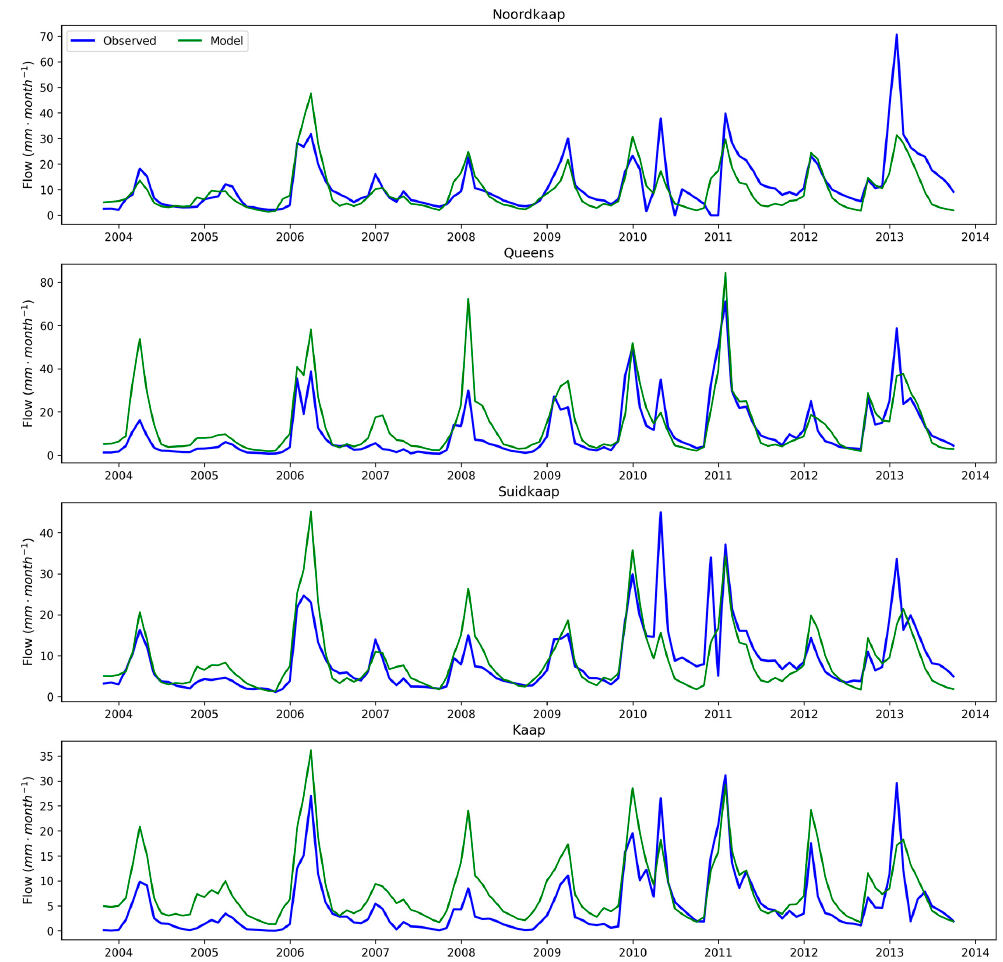
Figure 8. Monthly hydrographs for the four catchments, using results of run 64.